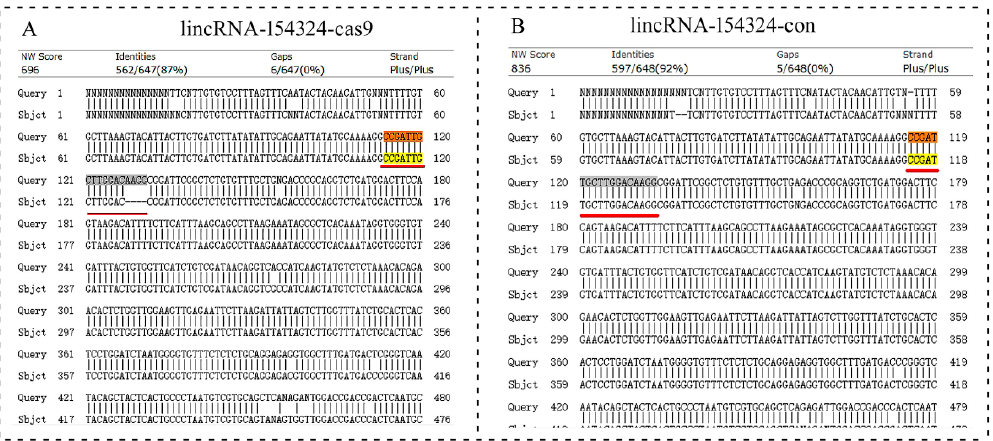
Figure 9. The sequence detection results for lincRNA-154324 knockout. ( A ) Alignment of caudal fin sequences from the control and the lincRNA-154324-cas9-knockout F0-generation adult zebrafish. ( B ) Alignment of caudal fin sequences from the control and the lincRNA-154324-con F0-generation adult zebrafish. Highlight, red line and red box: indicates the knockout target site area.